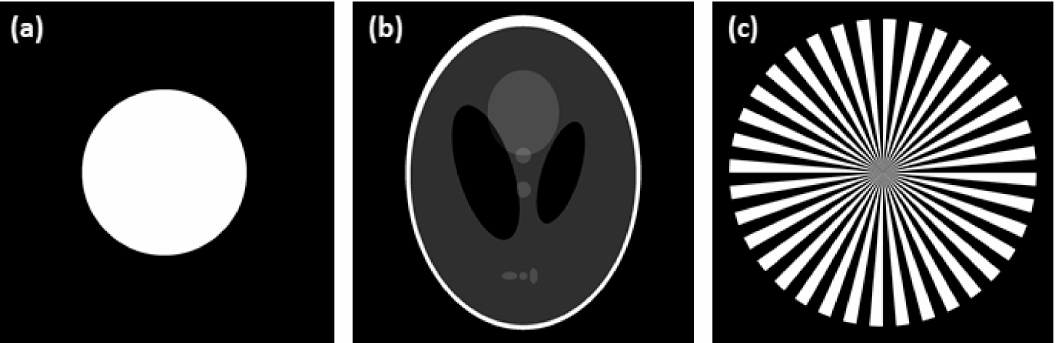
Figure 4. Synthetic data used for testing and validation of all tested methods: ( a ) ball phantom; ( b ) Shepp-Logan phantom; ( c ) Siemens star phantom.